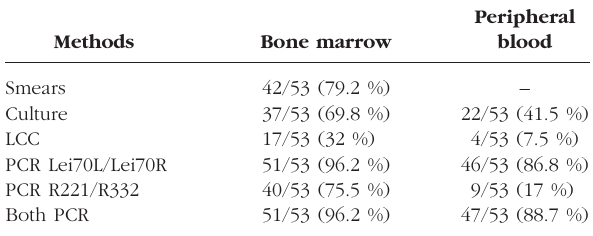
Table II. – Performances of PCR methods and classical methods for visceral leishmaniasis diagnosis according to the nature of samples.